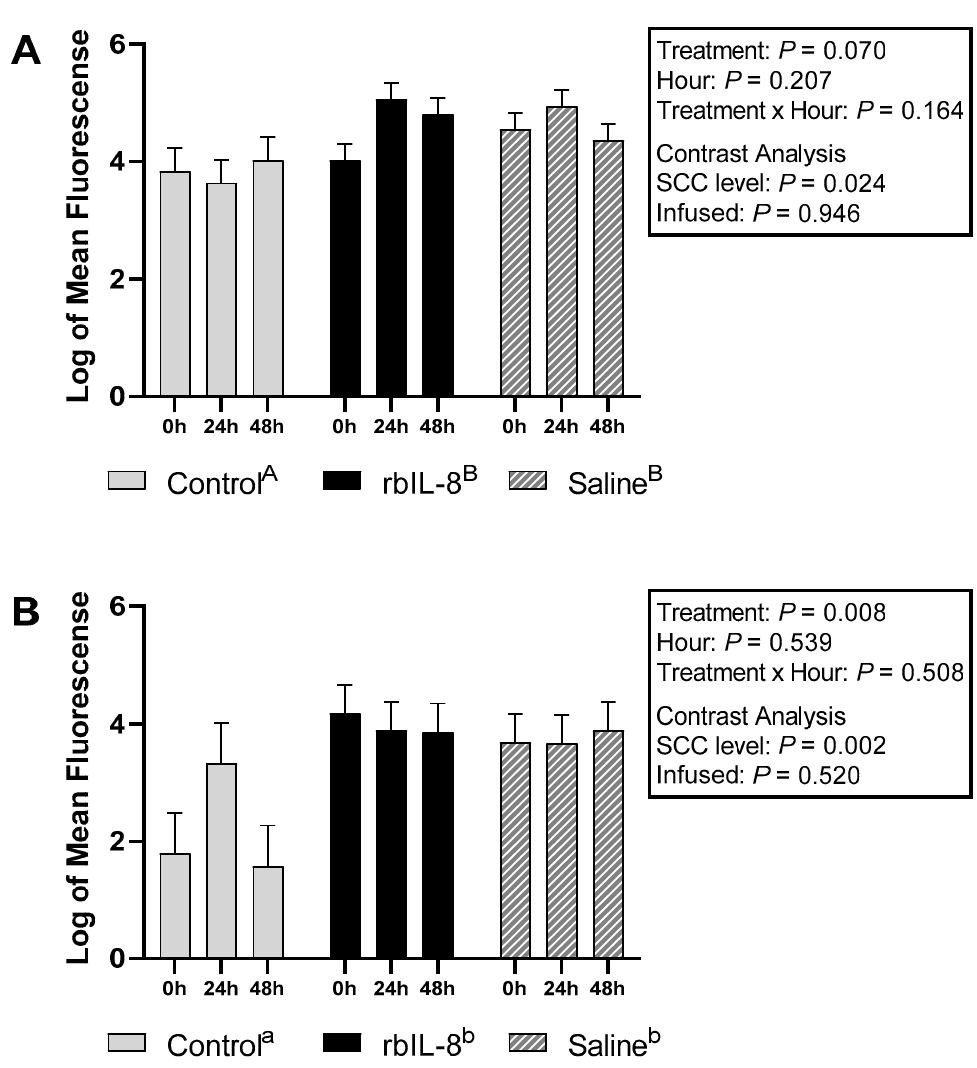
Figure 6. Mean fluorescence for neutrophils isolated from milk samples, for each respective dye, propidium iodide ( A ) and dihydrorhodamine ( B ), relative to hours post-treatment based on flow cytometry. Treatment effect is a multiple comparison among the groups. The SCC level was measured using a contrast comparing the chronic groups (rbIL-8 and saline) to the control, whereas the infused compares the rbIL-8 with the saline. Multiple comparisons were adjusted for Tukey–Kramer. Groups with different superscript a,b differed and A,B presented a tendency for the mean ± SE of log of neutrophils, in the multiple comparison analysis; p = ≤ 0.05 means a statistical significance, and 0.05 < p ≤ 0.10 means a statistical tendency.